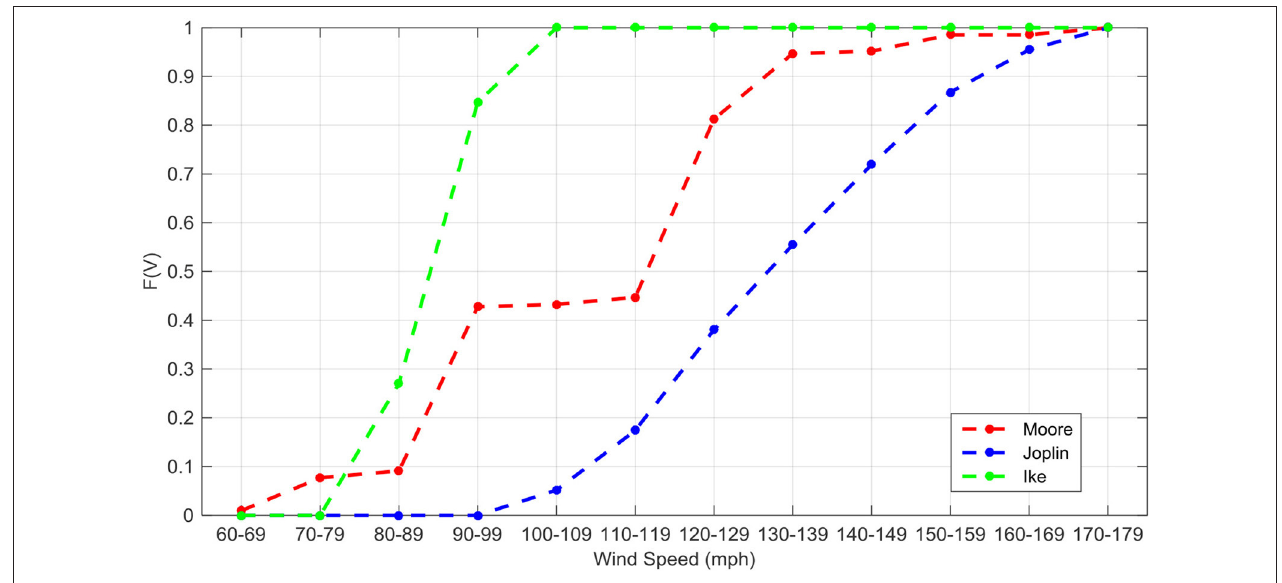
FIGURE 4 | Normalized cumulative percentage, F(V), of damaged homes by wind speed range.